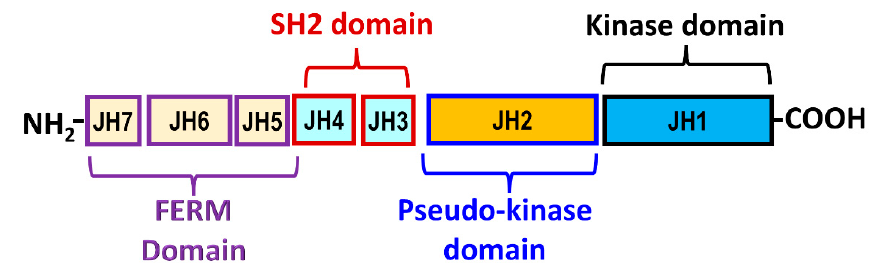
Figure 1. Domain structure of JAKs.